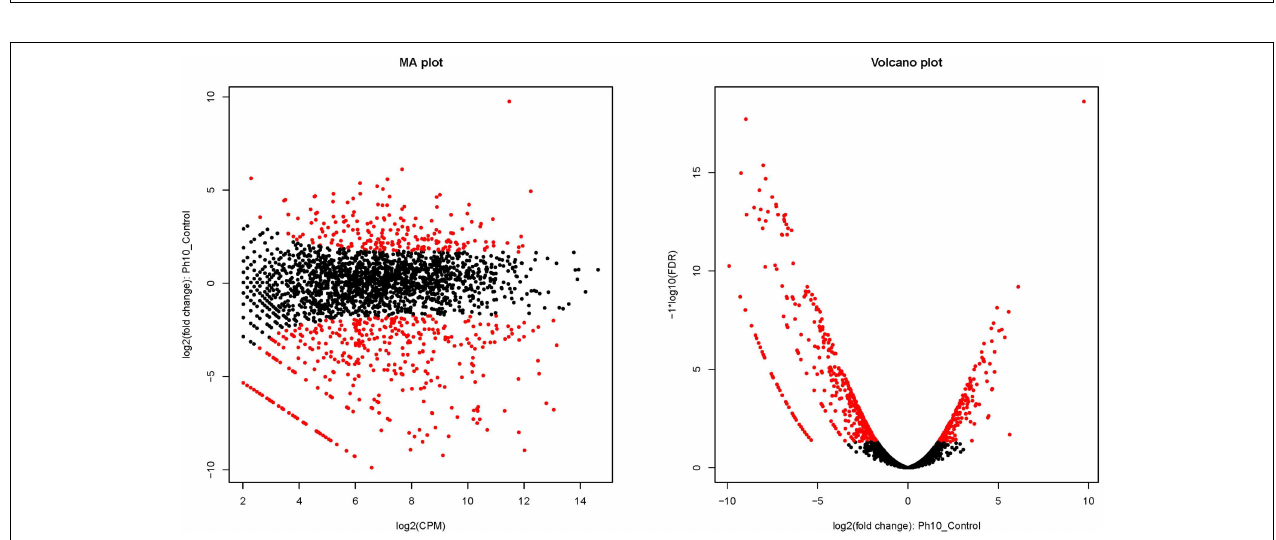
FIGURE 4 | Differentially expressed genes of E. faecalis cultured in pH 10 media. Red dots indicate differentially expressed genes. Black-colored dots were not considered as significantly differentially expressed. In the figure of the MA plot, the X-axis shows the average count of reads per million reads based on a log 2 scale, and the Y-axis